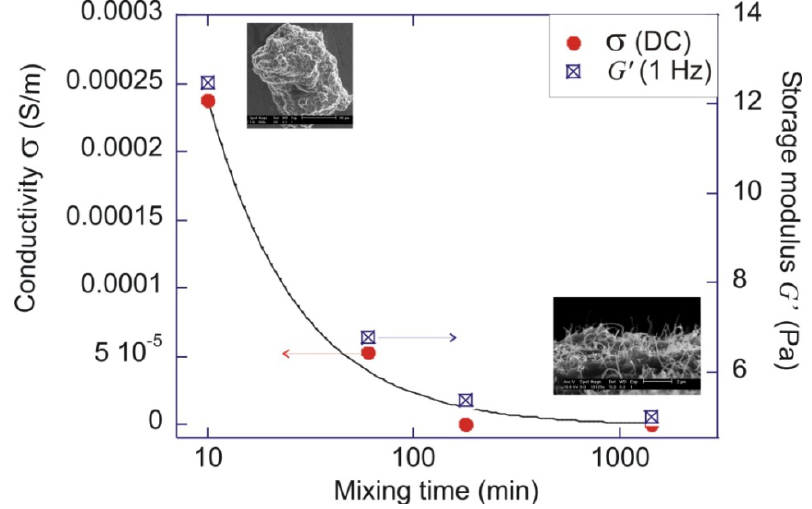
Figure 6. Plot of DC conductivity σ , and the shear storage modulus G’ at 1 Hz, for pure 2 wt% MWNTs-PDMS composites mechanically mixed for different times. The result indicates a strong correlation between the DC conductivity and the amount of non-dispersed CNT clusters present in the